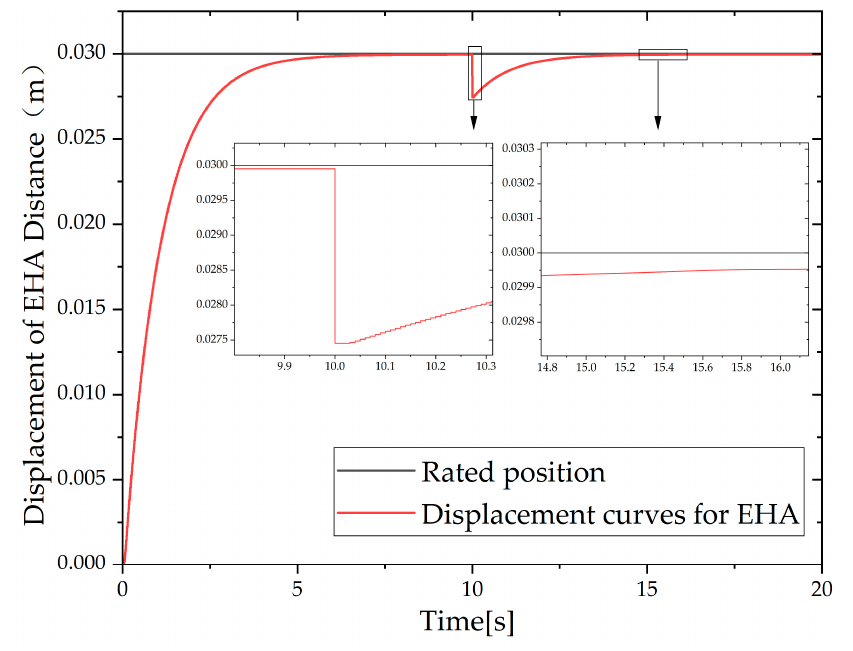
Figure 19. Fuzzy PID control step response curve.